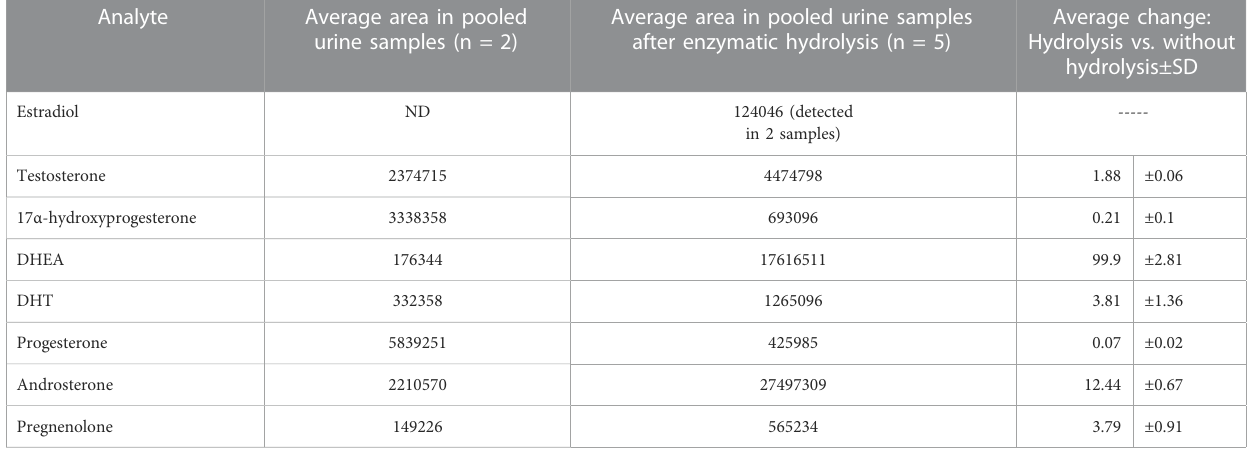
Table legend: SD — Standard